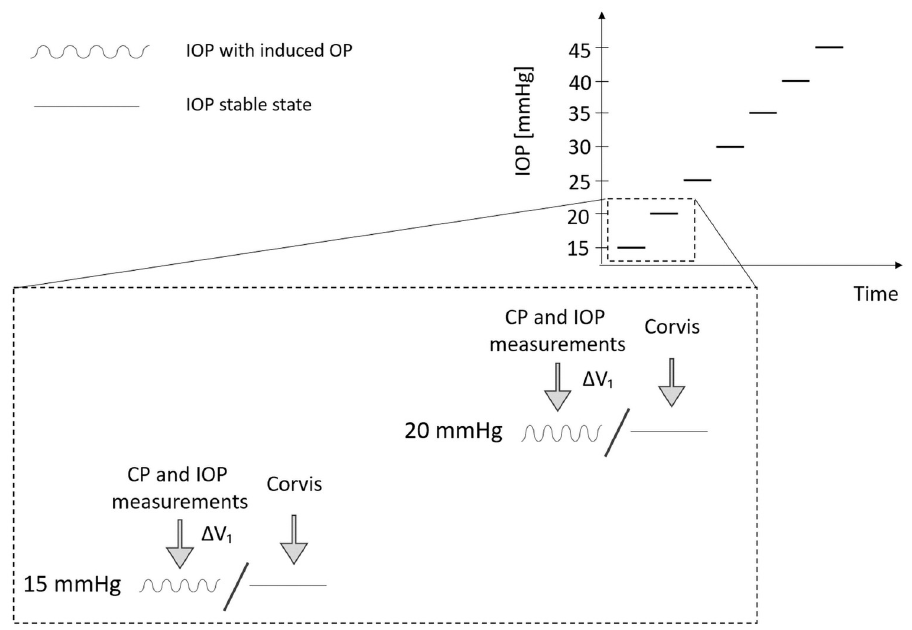
Fig 3. A scheme of the CP and IOP signal measurement procedure during ocular pulse (OP) simulations with constant infusion/withdrawal PBS volume ( Δ V) together with corneal biomechanical measurements in the seven- step inflation